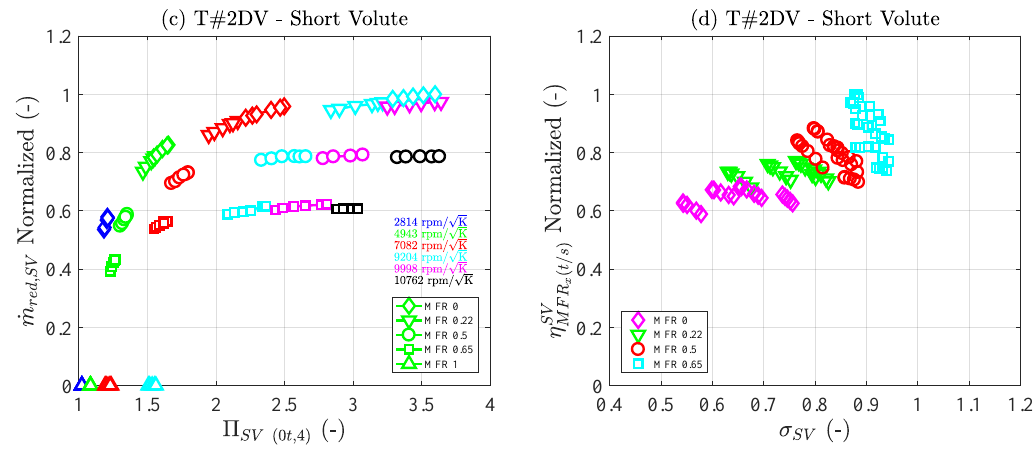
Figure 6. Turbine flow and efficiency maps of a dual-volute turbocharger